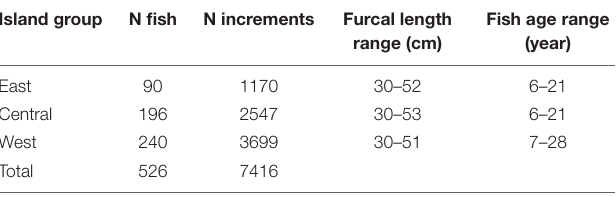
TABLE 1 | Summary of Pagellus bogaraveo samples used in the